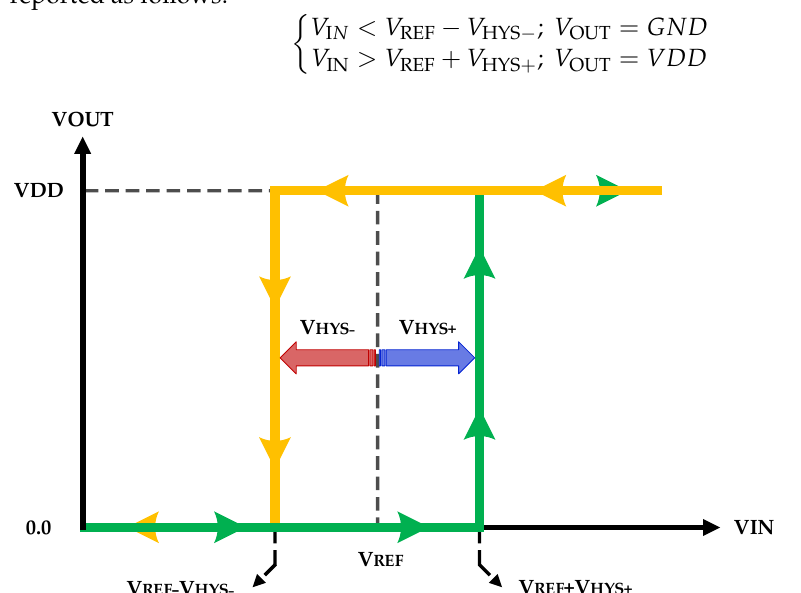
Figure 4. Loop characteristics of a non-inverting comparator. Figure 5 indicates the schematic of the employed hysteresis comparator in this work.